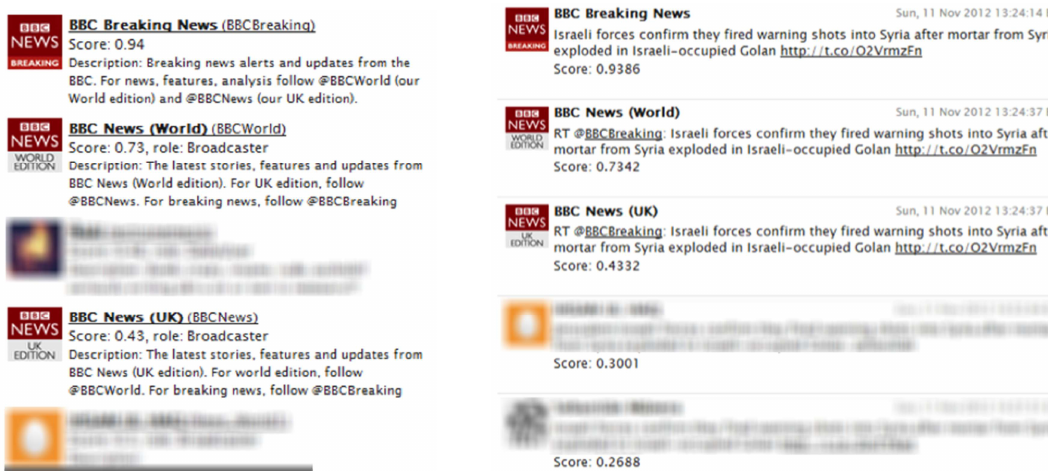
Figure 11: WeGov Analysis Components – Top Users to Watch (Cp. left) and Top Posts to Watch (Cp.